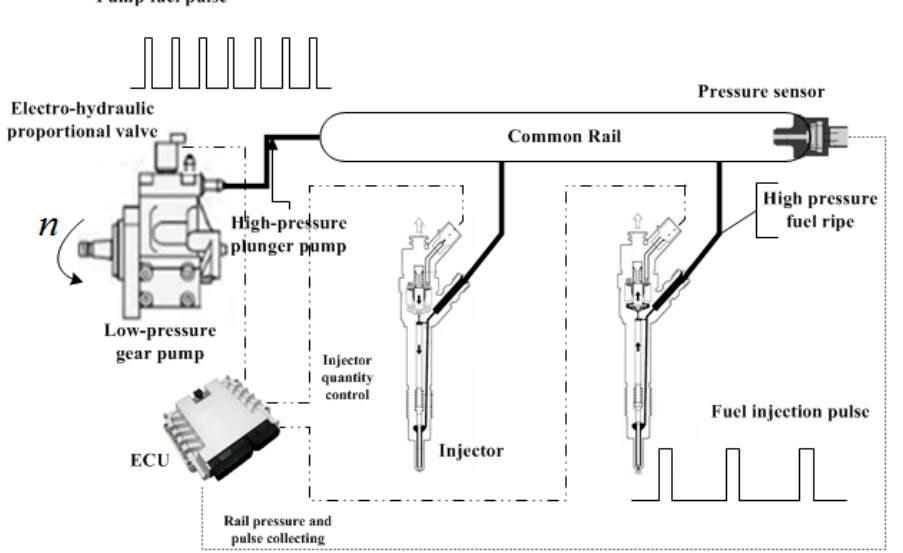
Figure 3. A block scheme of the common rail injection system for diesel engines.